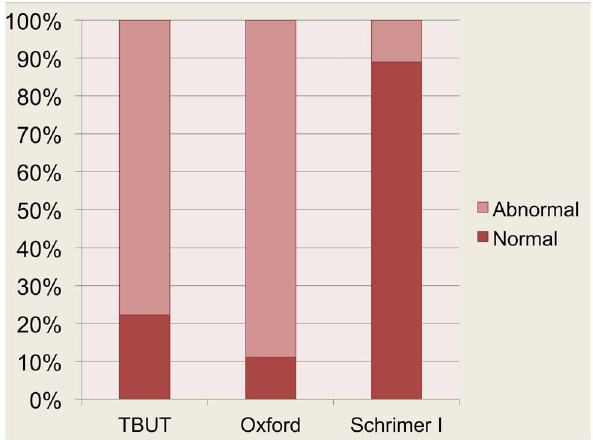
Figure 1. Percentage of patients with/without signs who reported OSDI symptoms. The results between the presences of symptoms assessed by the OSDI questionnaire in combination with one of the clinical tests. Patients with OSDI symptoms often had decreased TBUT (77.78%) and abnormal Oxford Schema (88.89%) scores in contrast to Schirmer I test without anesthesia. According to the Schirmer I test without anesthesia, 88.89% had a normal test.